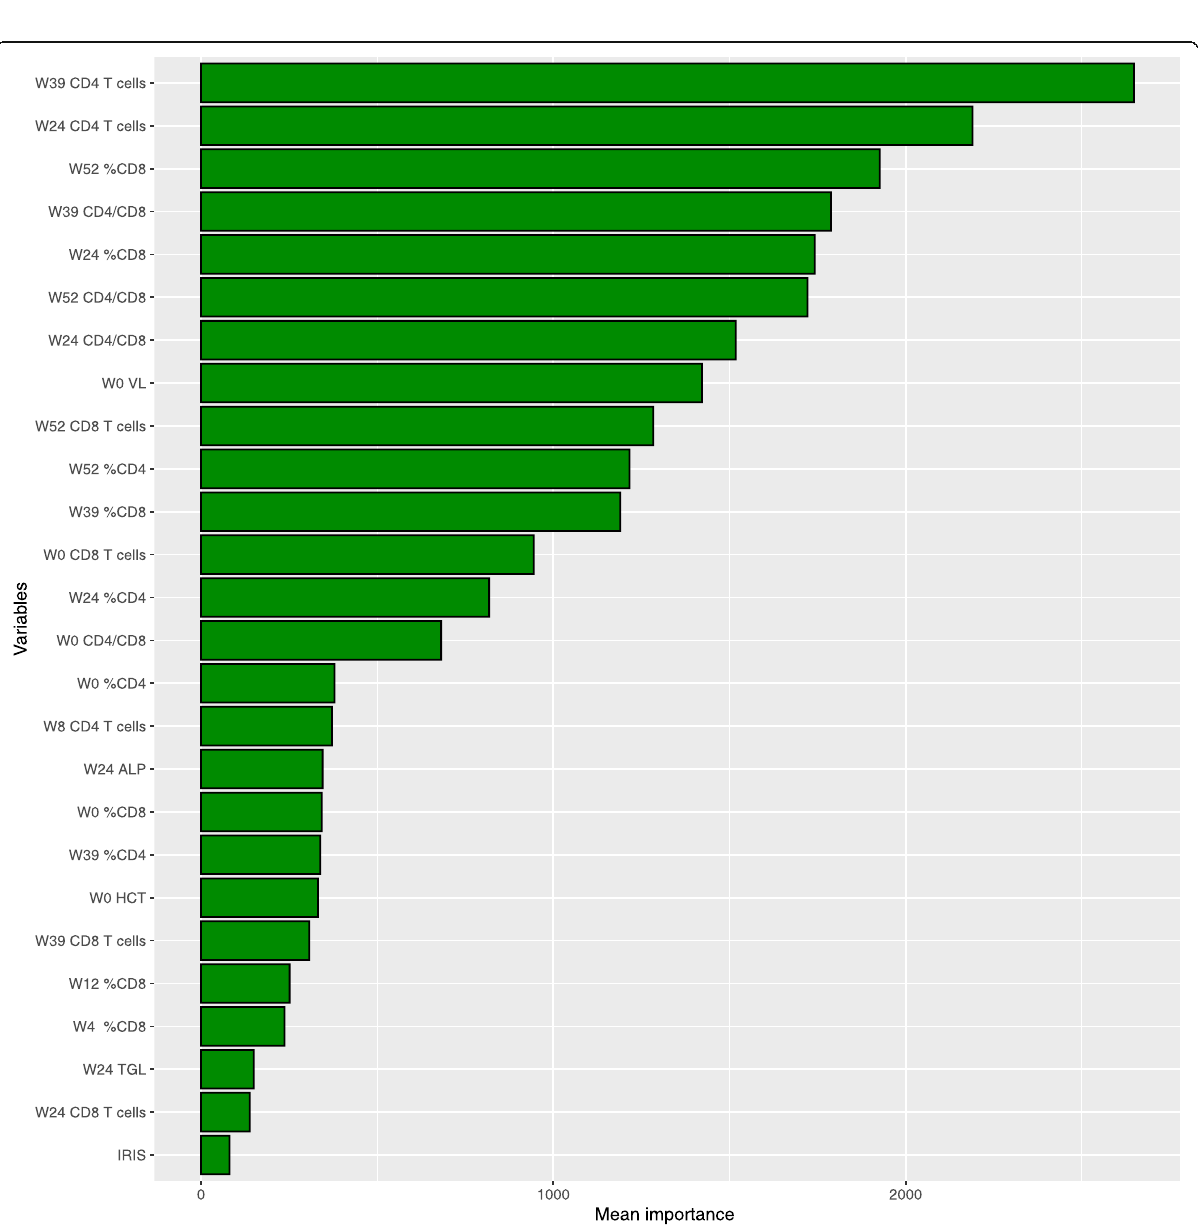
Fig. 4 Mean importance coefficients obtained by conditional inference random forest analysis. Variables with positive coefficients (contributing to the prediction of delta CD4) are